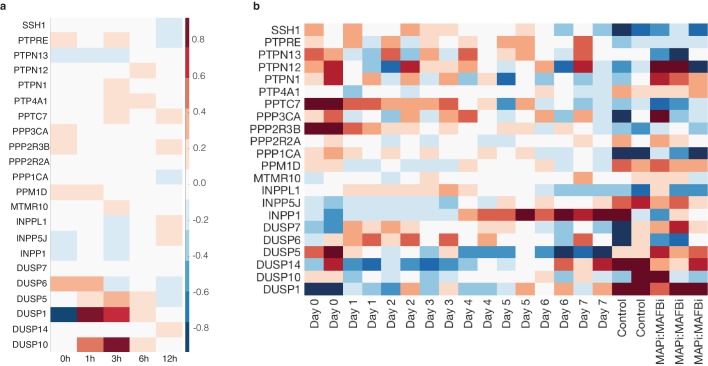
Expression in published datasets of the protein phosphatases identified by suspension-induced differentiation.(a) Heatmap showing mRNA expression of candidate phosphatases during calcium-induced stratification of primary human keratinocytes (GSE38628). (b) Heatmap showing mRNA expression of candidate phosphatases during ex vivo human epidermal reconstitution (GSE52651).